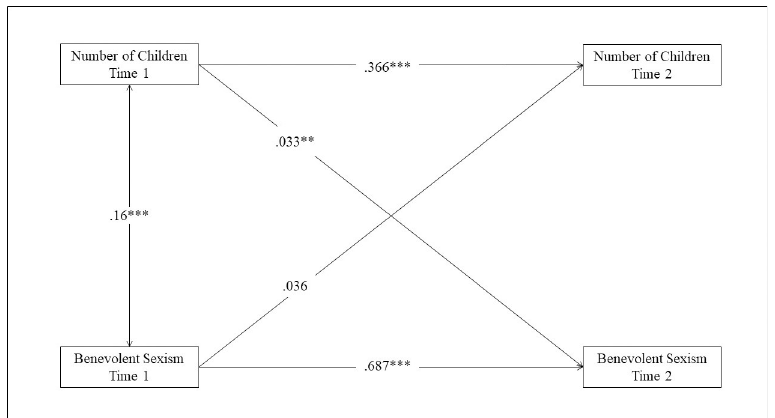
Fig 1. Cross-lagged panel analysis predicting number of children and benevolent sexism over a two-year time period while adjusting for the effects of covariates and the zero-inflation component of people’s number of children. ( N = 6017, ��� p < .001; �� p <